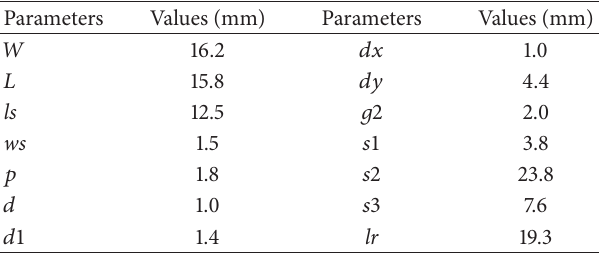
Table 1: The values of the simulated design